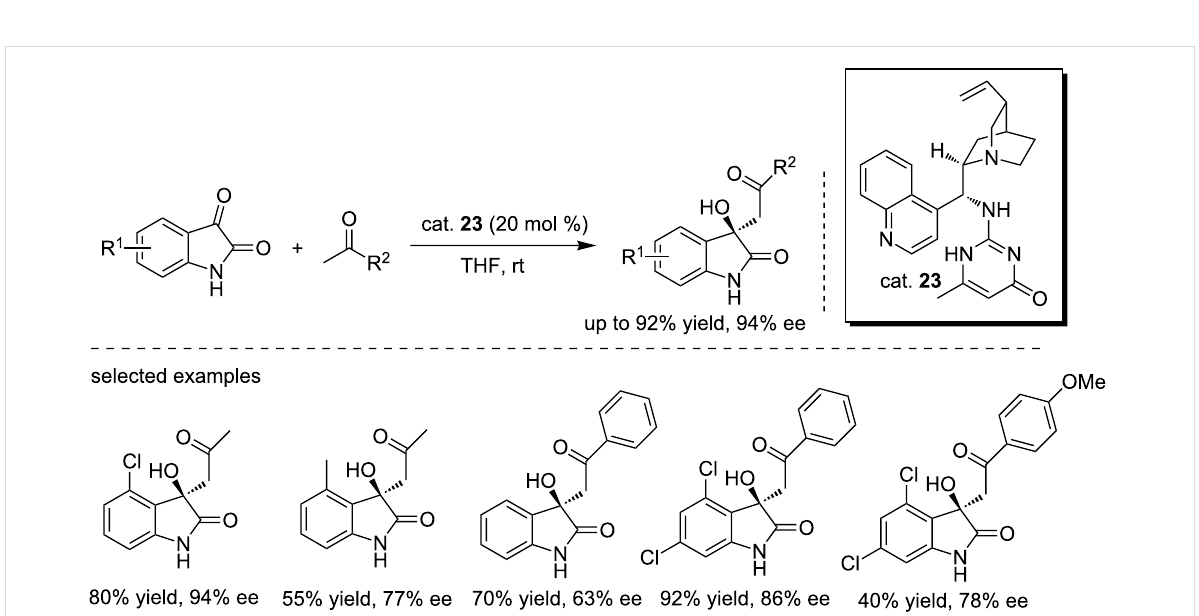
Scheme 38: Enantioselective aldol reaction of isatins with